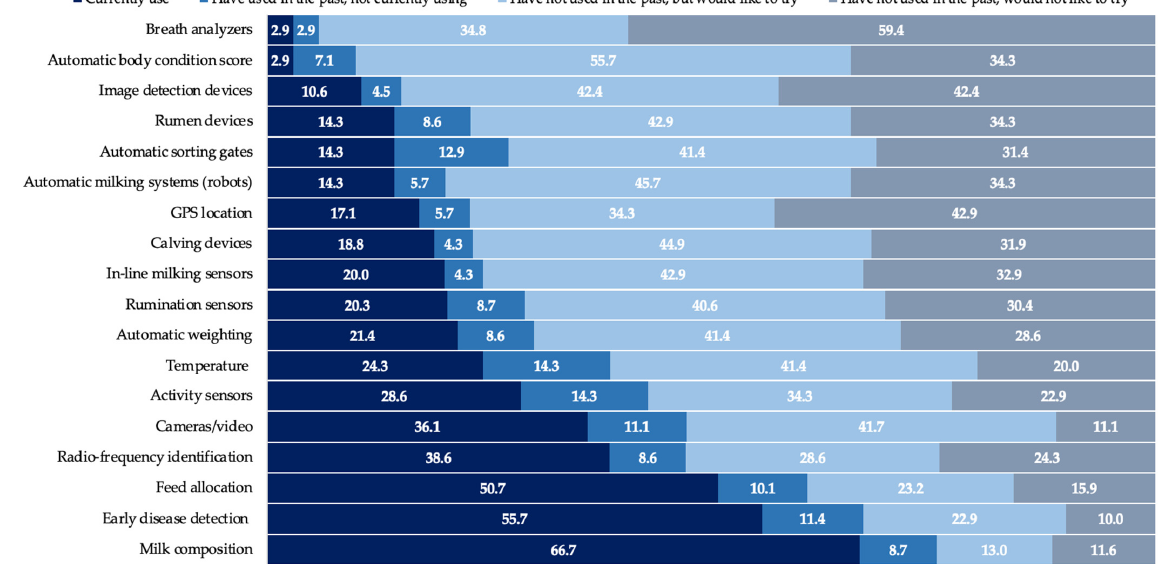
Figure 5. Use of technologies on dairy farms. The numbers inside the bars represent the percentage of responses for each usage category by type of technology. of responses for each usage category by type of